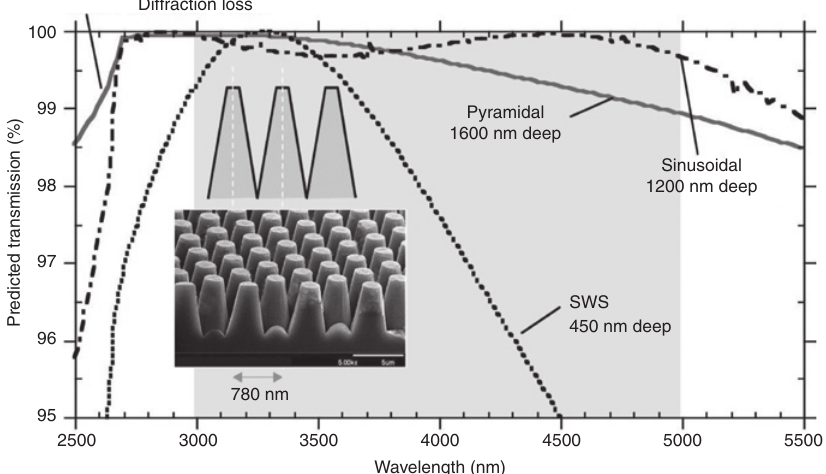
Figure 10: Predicted transmission of MWIR light propagating from air through an AR texture into silicon for various profile structures [179].